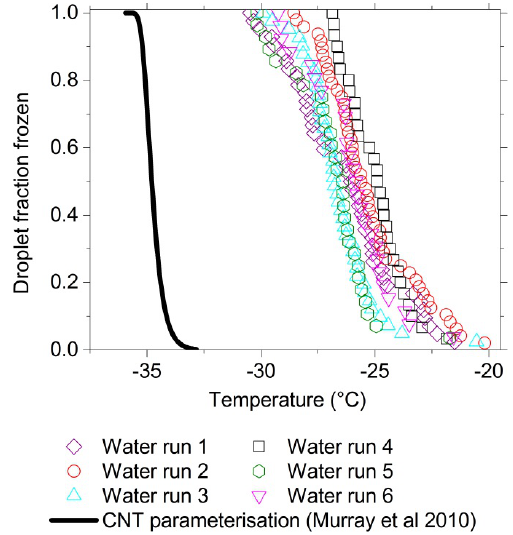
Figure 3. Temperature against fraction frozen for six different ex- periments using Milli-Q water. Also included is a line indicating the temperature of freezing expected for 1µL pure water droplets from classical nucleation theory (CNT) according to the parameterisation by Murray et al.